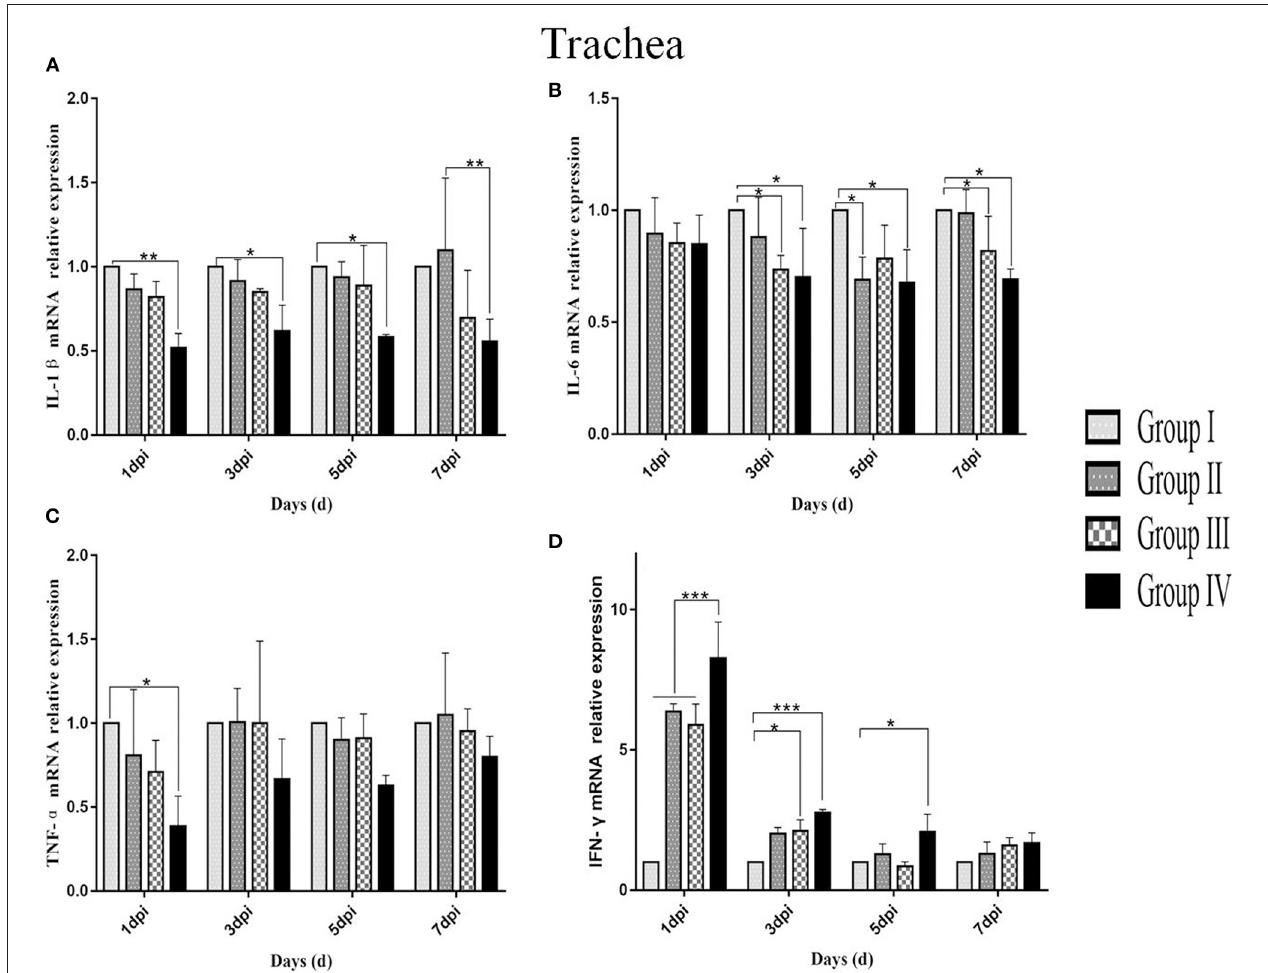
FIGURE 7 | Relative mRNA expressions of IL-1 β , IL-6, TNF- α , and IFN- γ in tracheas at 1, 3, 5, and 7 dpi. (A – D) Represent IL-1 β , IL-6, TNF- α , and IFN- γ mRNA relative expression in trachea, respectively. Group I served as a control. Broilers in Group II were given doxycycline whereas Group III was given SGDL granule through drinking water. Broilers in Group IV were given SGDL granule and doxycycline in drinking water. It was intraocularly and intranasally challenged by IBV at day 28. Extremely significant ( p < 0.005) different values are shown with ***, extremely significant ( p < 0.01) different values are shown with **, significantly ( p < 0.05) different values are shown with *, and no signal was not significantly ( p > 0.05) different between the groups at those time points. SGDL,